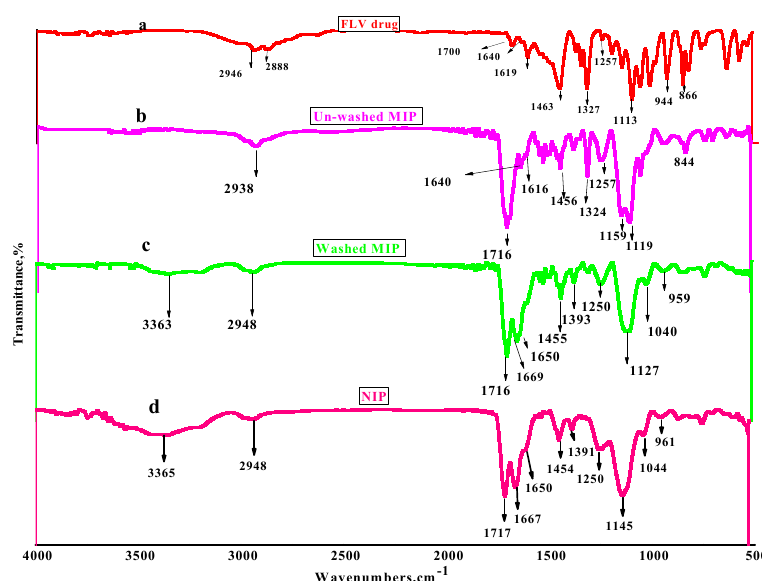
Figure 2. Fourier transform Infrared (FT-IR) spectra of fluvoxamine (FLV) ( a ), non-washed MIP ( b ), washed MIP ( c ) and NIP beads ( d ).